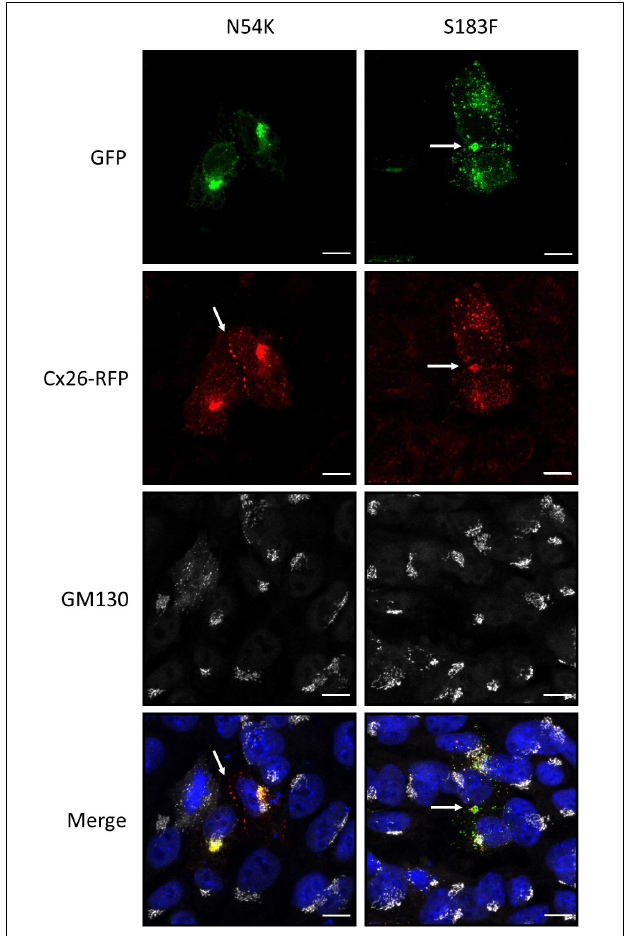
FIGURE 5 | The expression of Cx26-RFP did not alter the distribution of the N54K or S183F mutant. Representative micrographs of Cx43 KO HEI-OC1 cells co-expressing Cx26-RFP and N54K-GFP or S183F-GFP. Cells were immunolabeled with GM130 (white) to visualize the location of the Golgi apparatus and counterstained with Hoechst (blue) to demarcate the nuclei. Bars = 10 µ